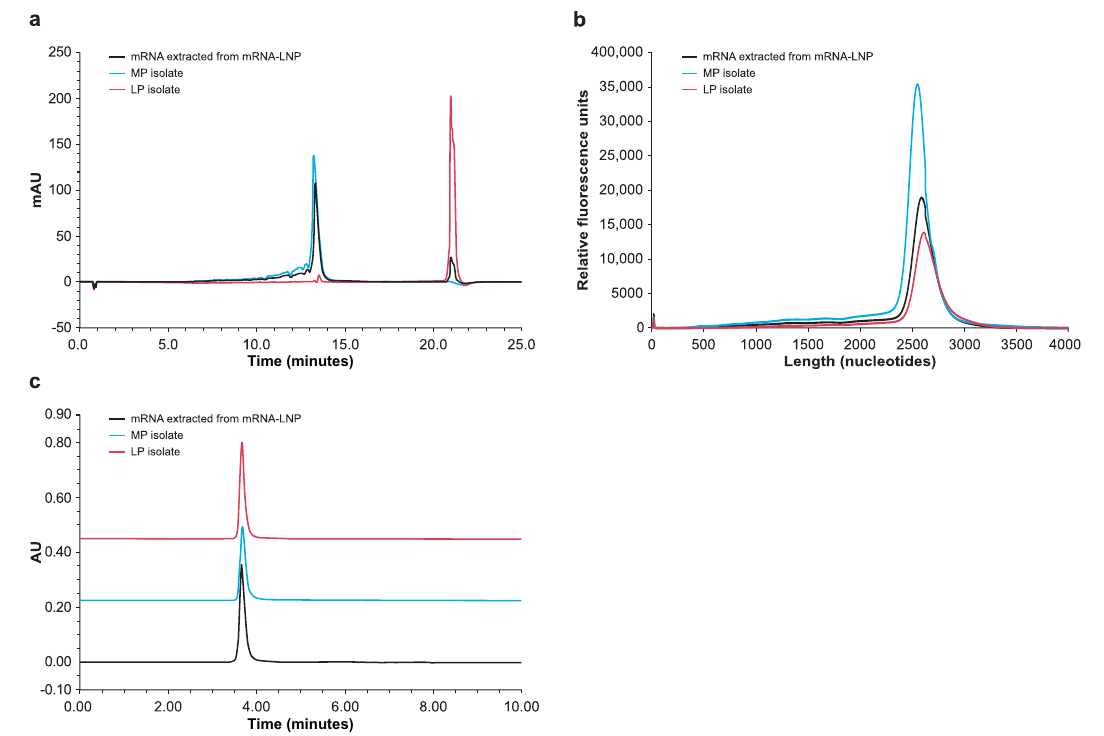
Fig. 2 Second dimension intact analysis of isolated MP and LP. a The reversed phase-ion pair high performance liquid chromatography (RP-IP HPLC) chromatogram of mRNA extracted from the mRNA-lipid nanoparticle (mRNA-LNP, black) is overlaid with RP-IP HPLC re-analysis of isolated mRNA main peak (MP, blue) and late eluting-peak (LP, red), showing preserved retention time of each isolated region. b The capillary electrophoresis (CE) electropherogram of mRNA extracted from the mRNA-LNP (black) is overlaid with electropherograms of the isolated MP (blue) and LP (red), showing no difference in migration time. c The size-exclusion chromatography (SEC) chromatograms of mRNA extracted from the mRNA-LNP (black) is overlaid with SEC chromatograms of isolated MP (blue) and LP (red), showing no presence of aggregation in either fraction. Representative data from 4 repeat experiments are shown. AU, absorption